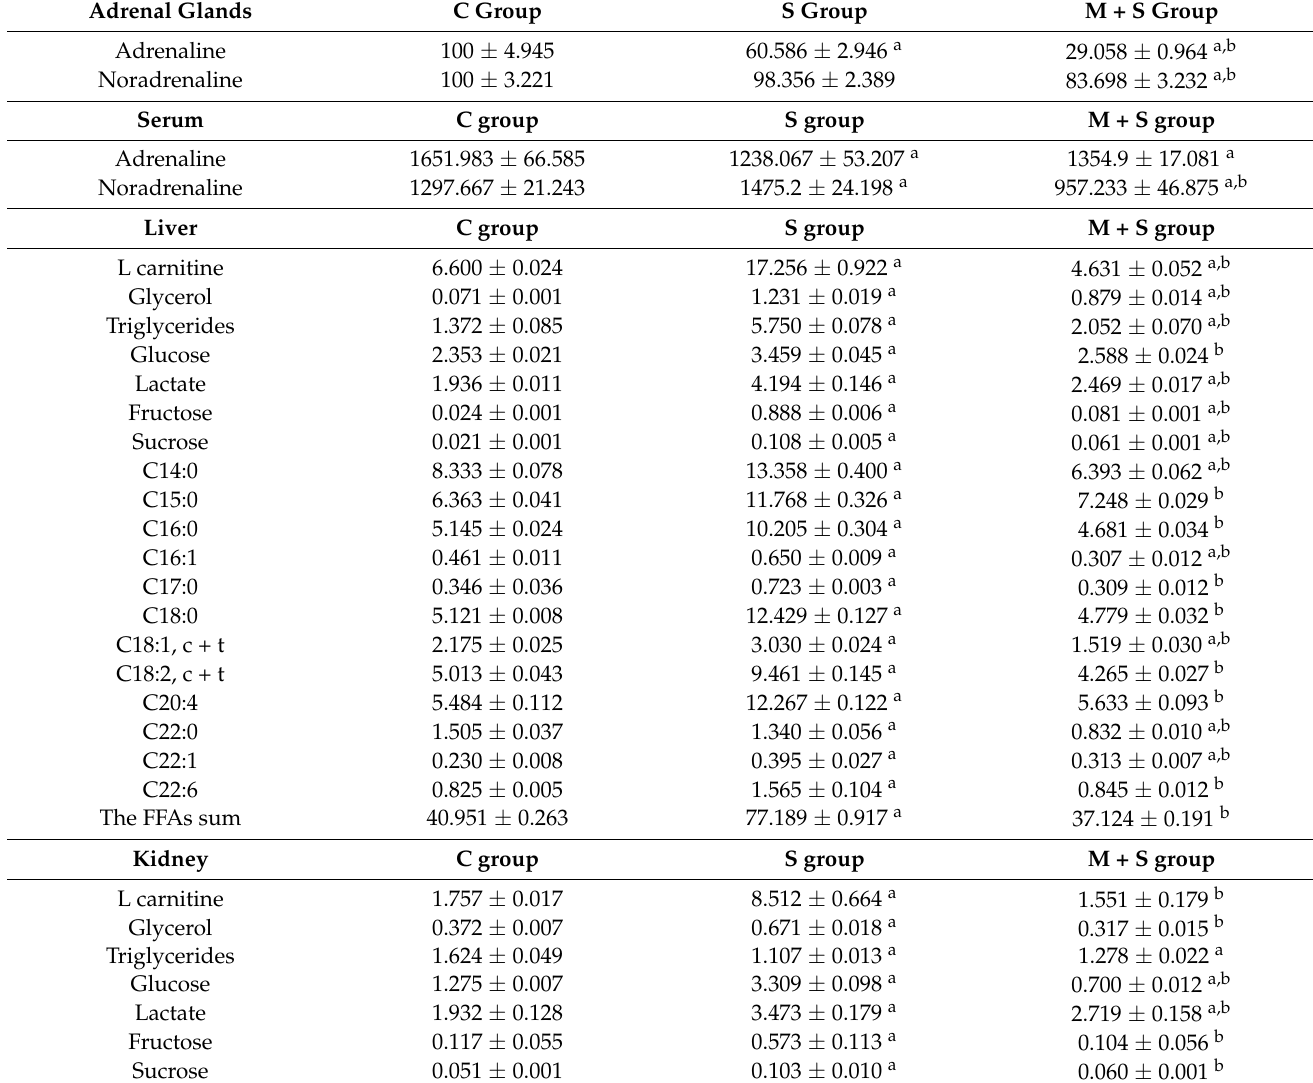
Table 3. Adrenal glands and serum adrenaline and noradrenaline concentrations and liver, kidney, and heart lipidomics in rats of control (C), sepsis (S), and meldonium + sepsis (M + S) groups. All units are given as mg/kg tissue.